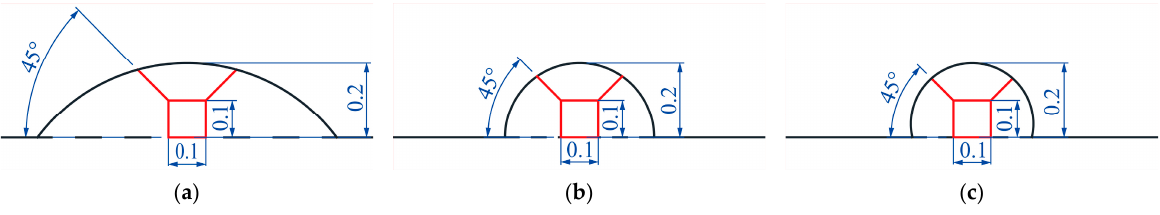
Figure 4. C-shaped topology in the vicinity of dimples. ( a ) Inferior arc (INF); ( b ) semicircle arc (SEM); ( c ) superior arc (SUP).